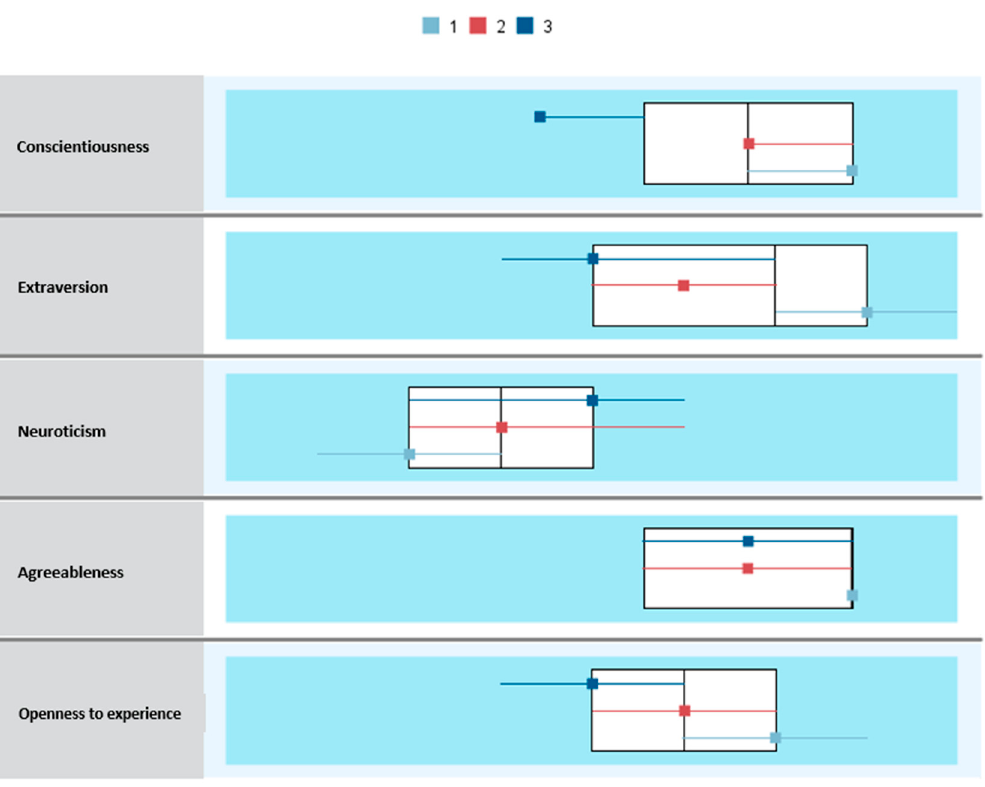
Figure 3. Comparison of clusters ( N = 1236).